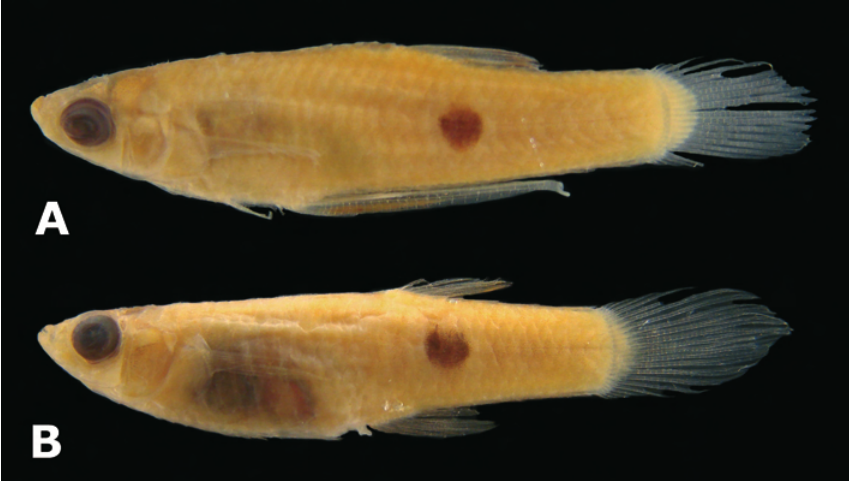
Fig. 2. Phalloceros mikrommatos . (A) Holotype, male, 20.4 mm SL, UFPB 5370, Porto Seguro, rio João de Tiba drainage,